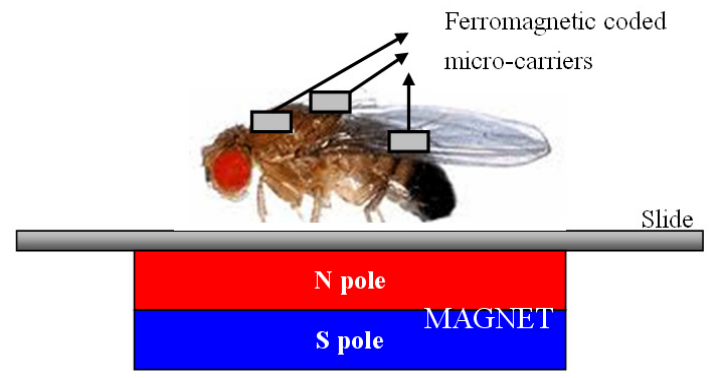
Figure 12. The diagram of ferromagnetic coded micro-carriers in vivo by testing the skin of Drosophila